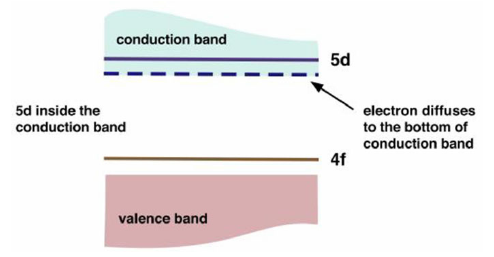
Fig. 6 Simple schematic model to illustrate the scenario for no Ce 3+ luminescence: lowest Ce 5d inside the host conduction band. Reproduced with permission from Ref. [57], © American Institute of Physics